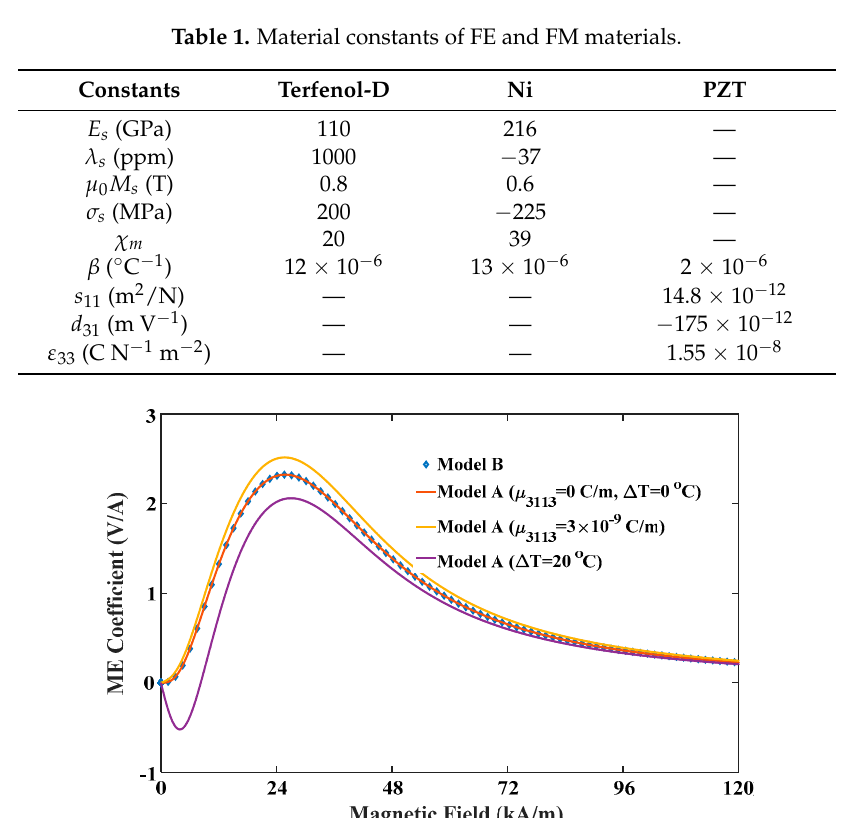
Figure 3. ME coefficients of Model B and Model A without flexoelectricity and temperature effect, only with flexoelectricity, and only with temperature effect.